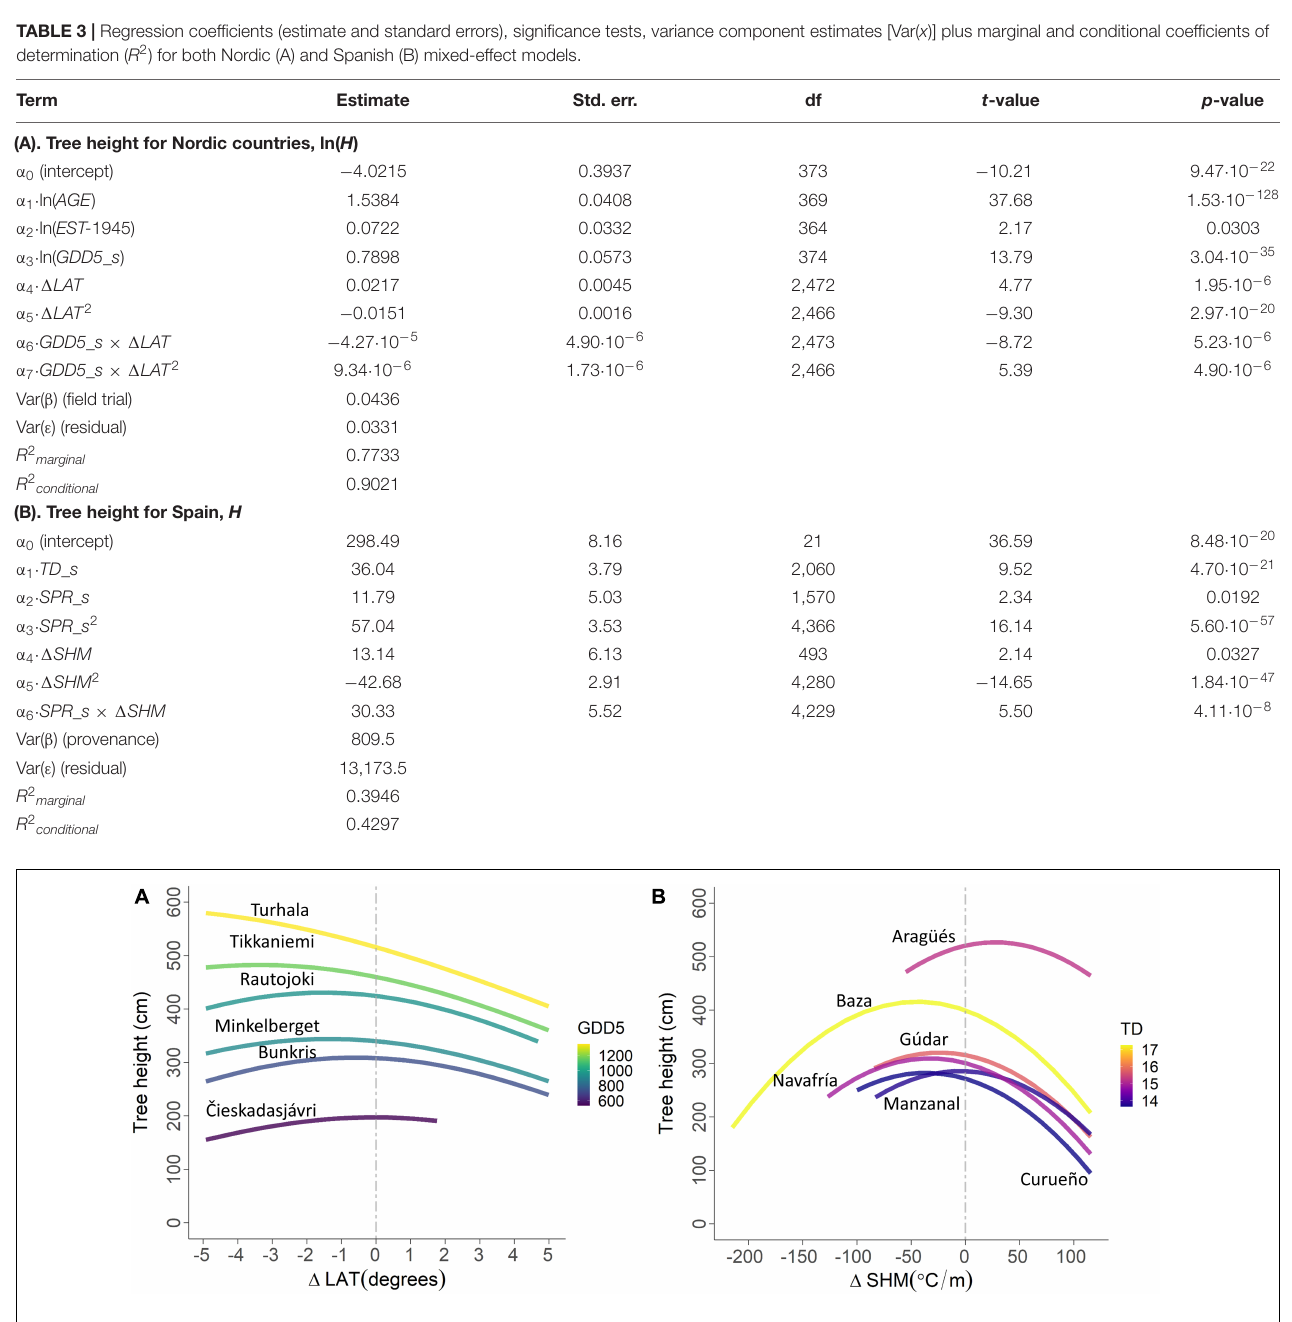
FIGURE 2 | Scots pine tree height predictions as a function of the environmental transfer distances for a sample of six field trials in the Nordic region (A) and for all six field trials in Spain (B) under the average climate during the growth of the trees (see Table 4 for details). The plotting of biologically unreasonable transfer distances such as Nordic provenances originating north of Nordkapp (71.19 ◦ N) or Spanish provenances with negative SHM values were